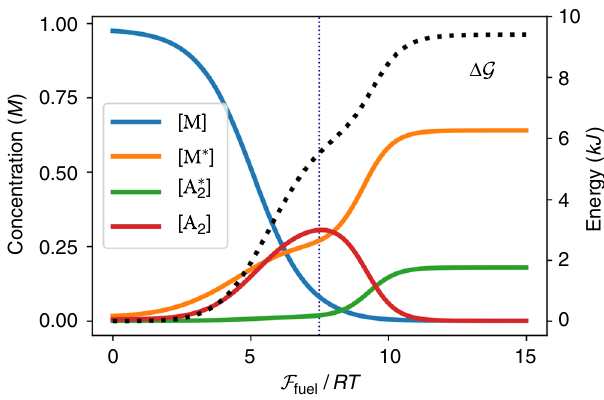
Fig. 3 Maintenance phase of energy storage. Stationary concentrations and free energy difference from equilibrium in the maintenance phase of energy storage as a function of the chemical potential difference between fuel and waste. The vertical dotted line denotes the value F study the charging phase in